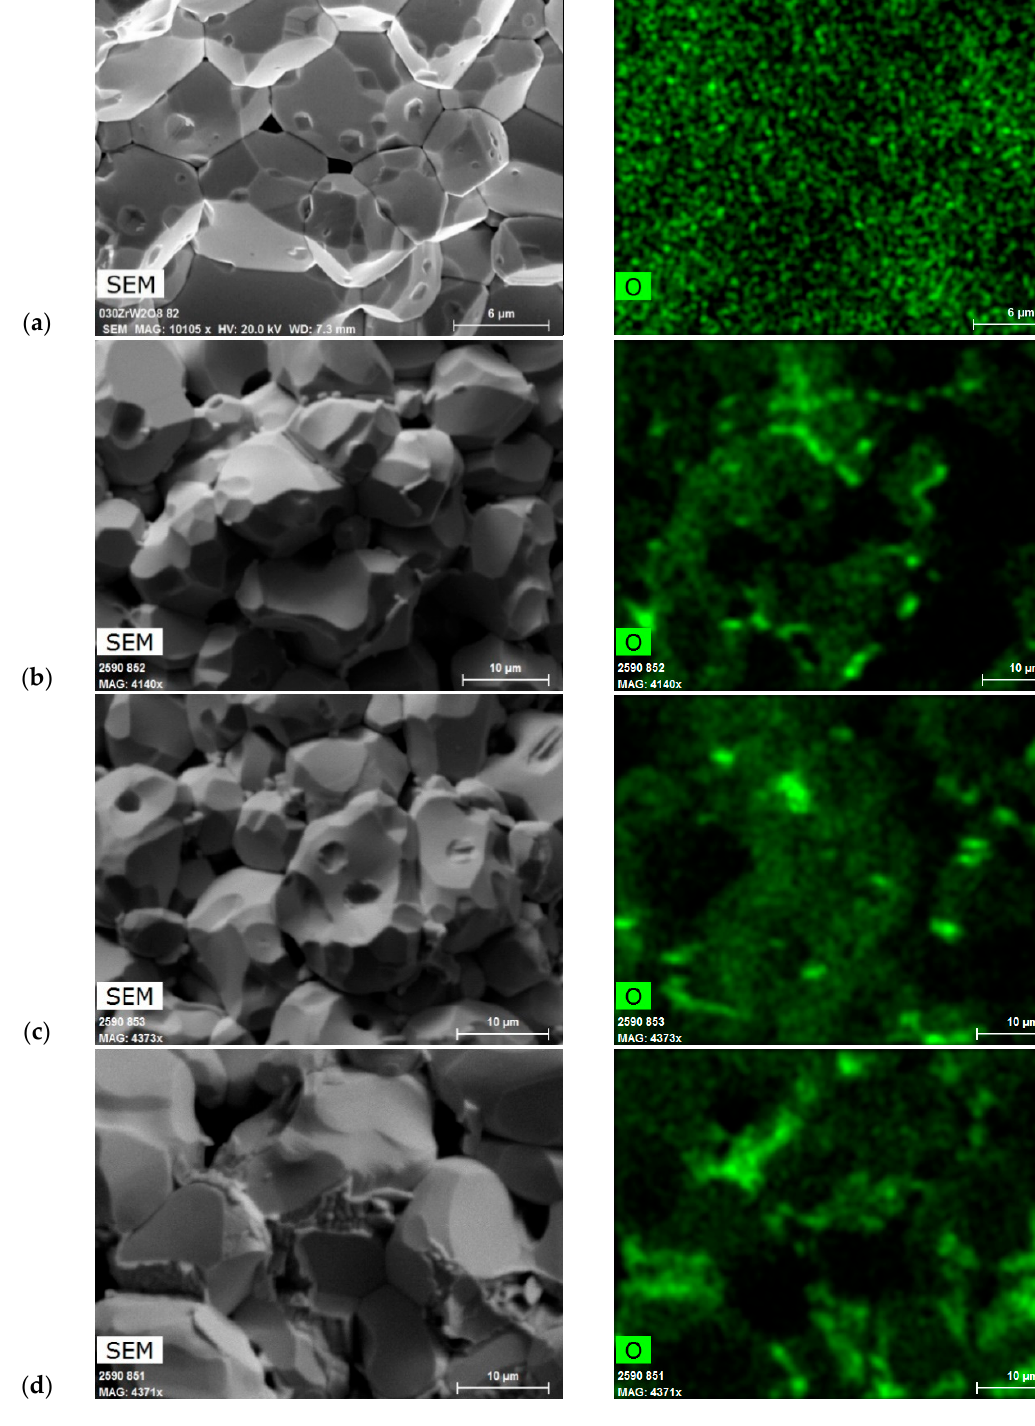
Figure 3. SEM images of fracture surfaces and corresponding O elemental maps of the CLC15 ( a ), CLW15 ( b ), ULC15 ( c ) and ULW15 ( d ) samples. Elemental maps of W and C were also acquired, but did not show notable trends, and thus, are not presented.